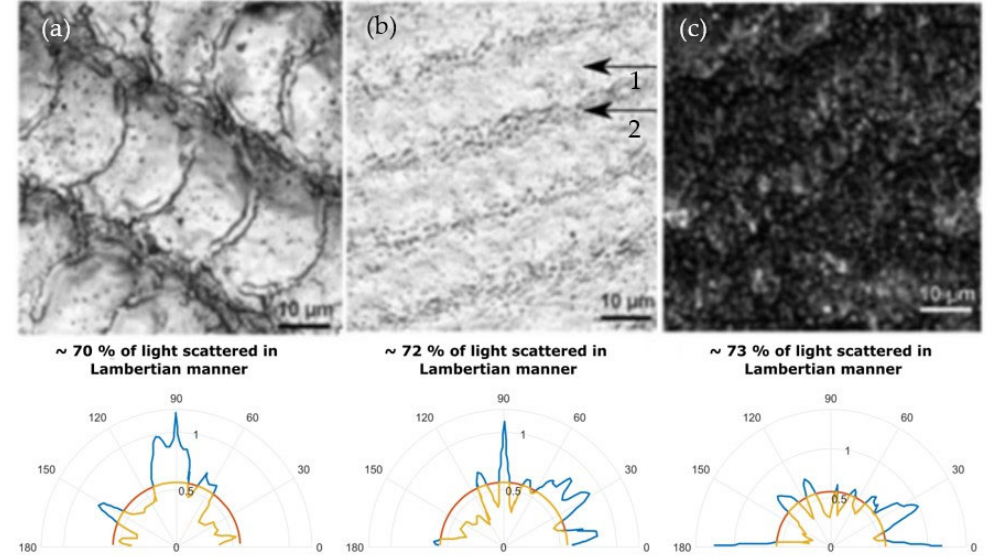
Figure 4. Laser microscope images of micromachined surfaces and their corresponding light scatter diagrams. ( a )—represents white, ( b )—gray and ( c )—black color surface. Top row is SEM images, while at the bottom row is the scattering angle diagrams of these surfaces.